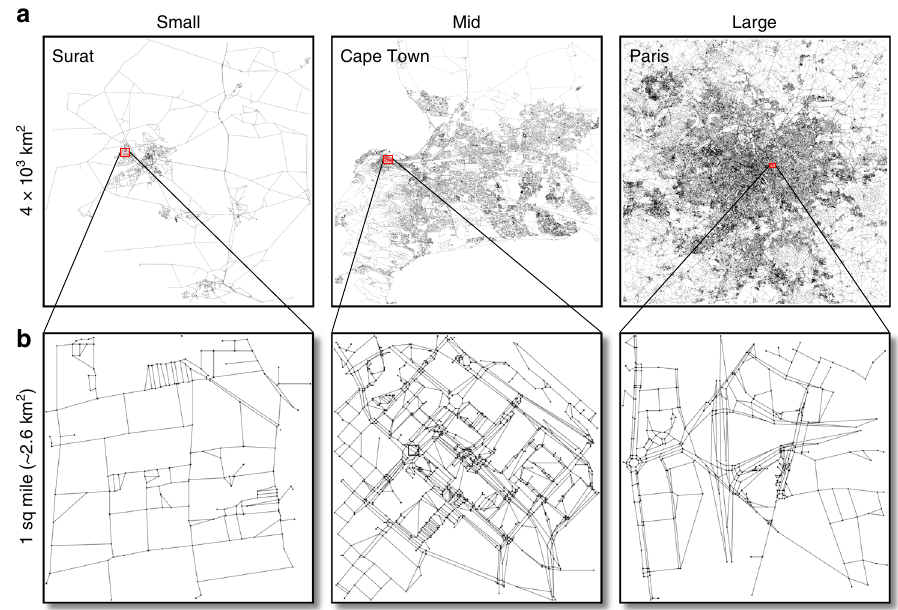
Fig. 1 Street networks at multiple scales Cities split into three categories based on the number of nodes (intersections) in the sampled street networks: small ( N ∼ 10 3 ), medium ( N ∼ 10 4 ) and large ( N ∼ 10 5 ). a The networks at the full sampled range. b Selected smaller samples (on the order of